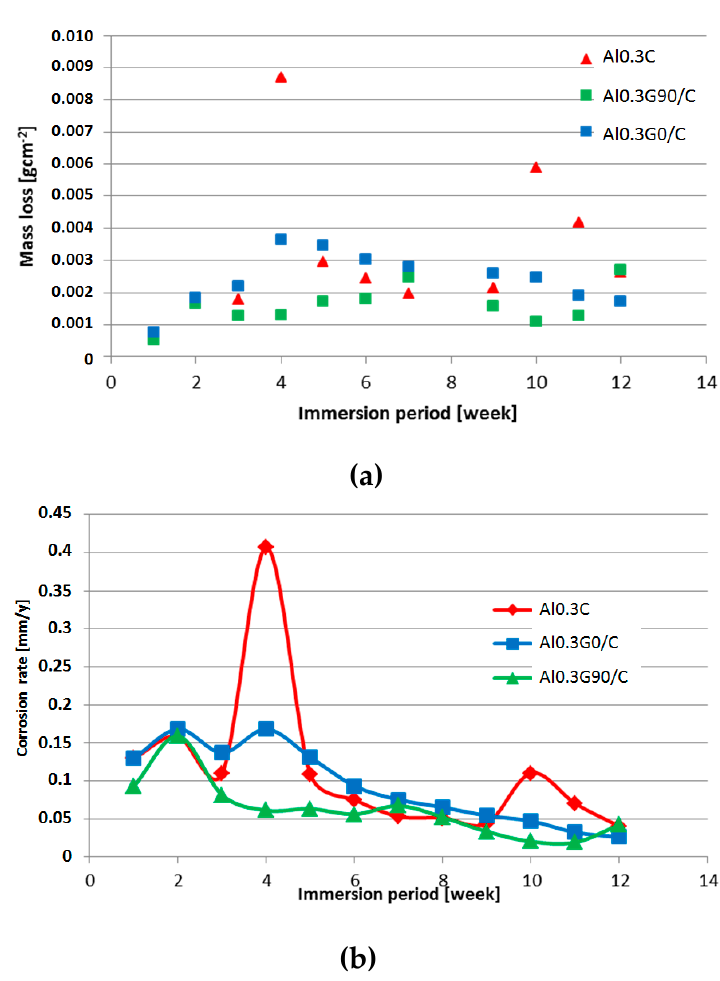
Figure 10 . Mass loss of the laminates during the 12 week test ( a ) and corrosion rate ( b ); 0.8 M NaCl;.